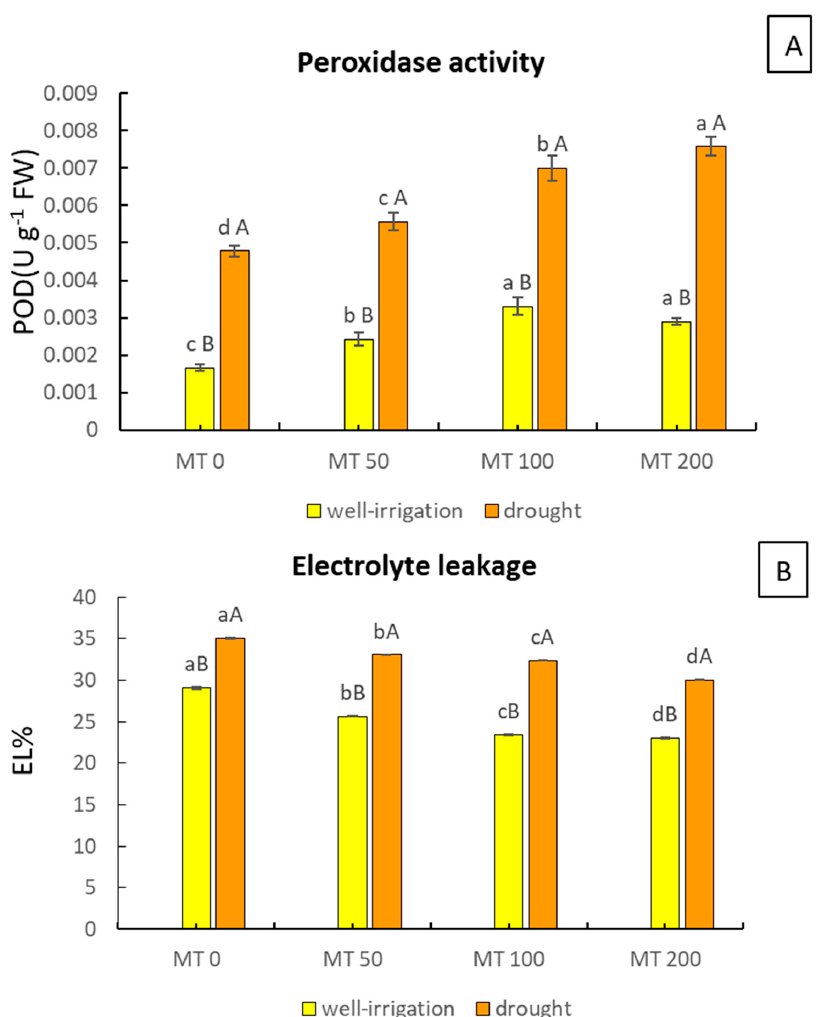
Figure 5. Effect of exogenous melatonin on peroxidase activity [POD (U g − 1 FW)] ( A ) and electrolyte leakage [EL (%)] ( B ) in R. asiaticus plants subjected to drought stress conditions. MT0, well-watered and drought-stressed plants without MT treatment; MT50, MT100, and MT200, treatment with different MT concentrations (50, 100, and 200 μ M, respectively) under non-stressful and stressful conditions. The values represent the mean ± standard deviation of at least five replicates. Lowercase letters: comparison of MT concentrations under fixed irrigation treatments; uppercase letters: comparison of the irrigation treatment groups under fixed MT concentration levels (Tukey/Games–Howell test, p <